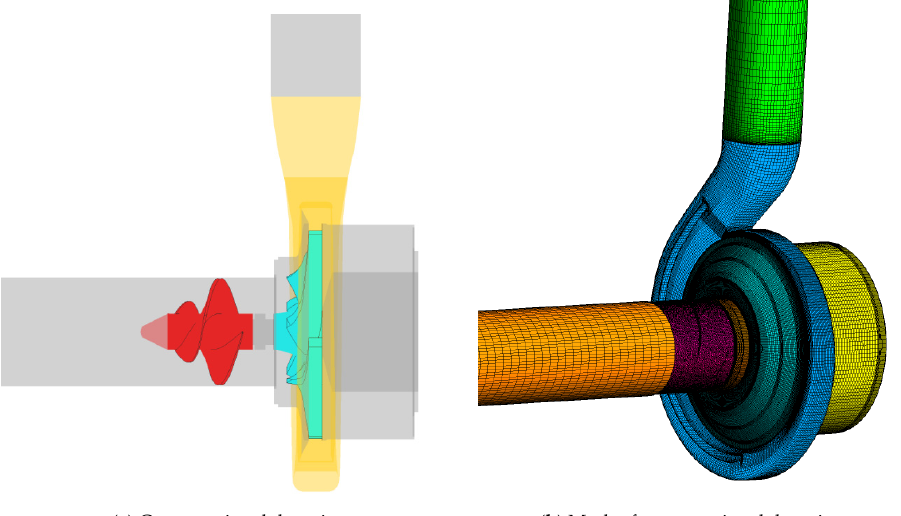
Table 3. Mesh No. of each domain.